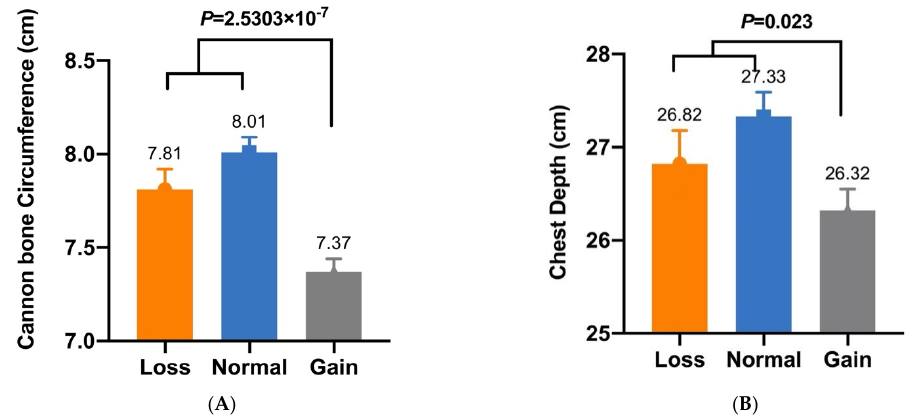
Figure 4. Association analysis between CNV3 and morphometric traits in SBWC goats: ( A ) cannon bone circumference and ( B ) chest depth.